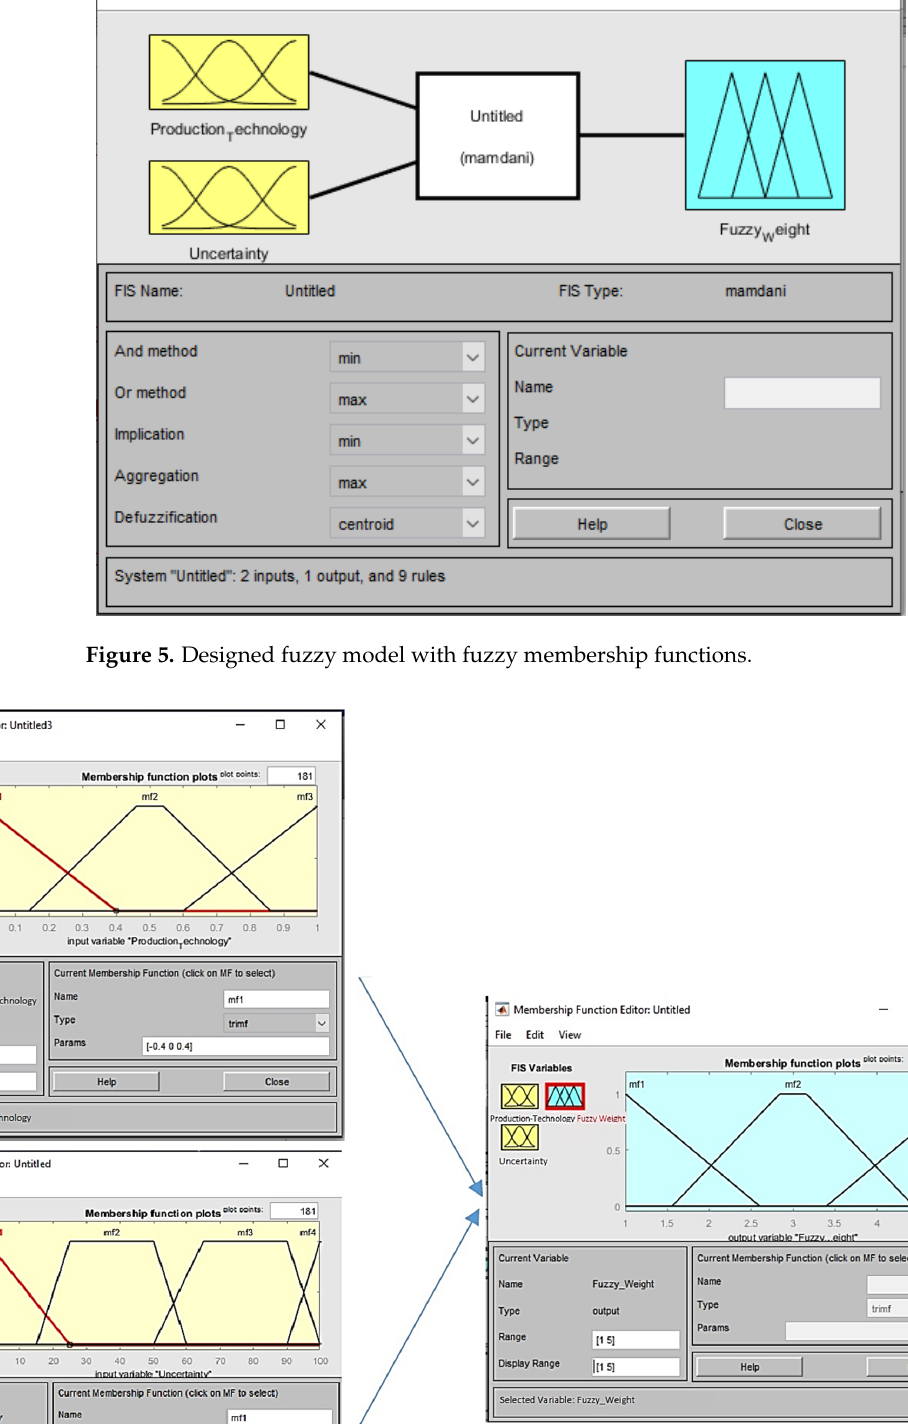
11 of 27 Figure 4. Trapezoidal distribution functions for a specific data set.